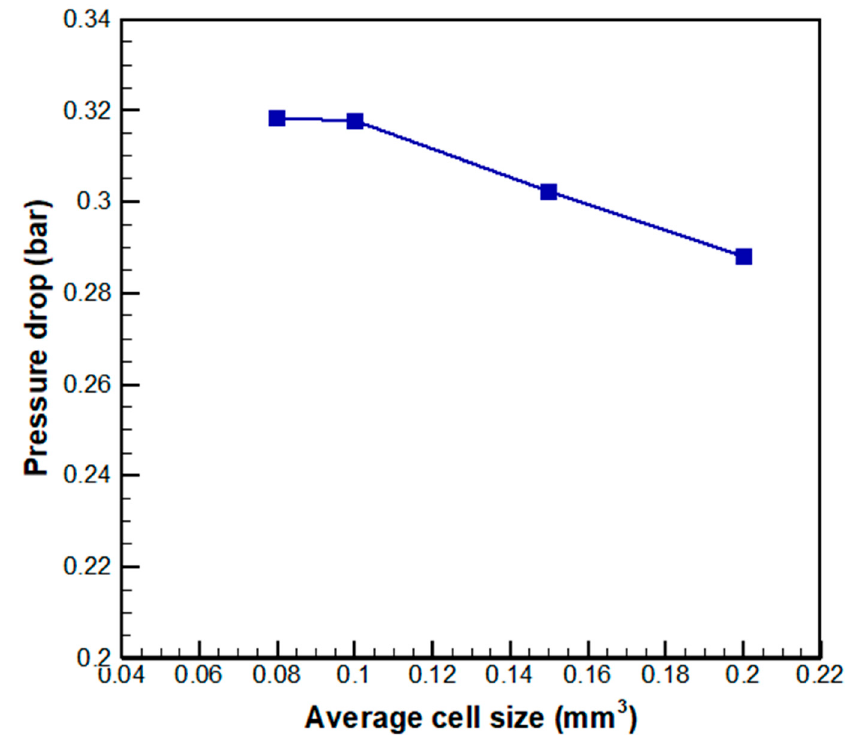
Figure 3. Grid dependency result for average cell size.